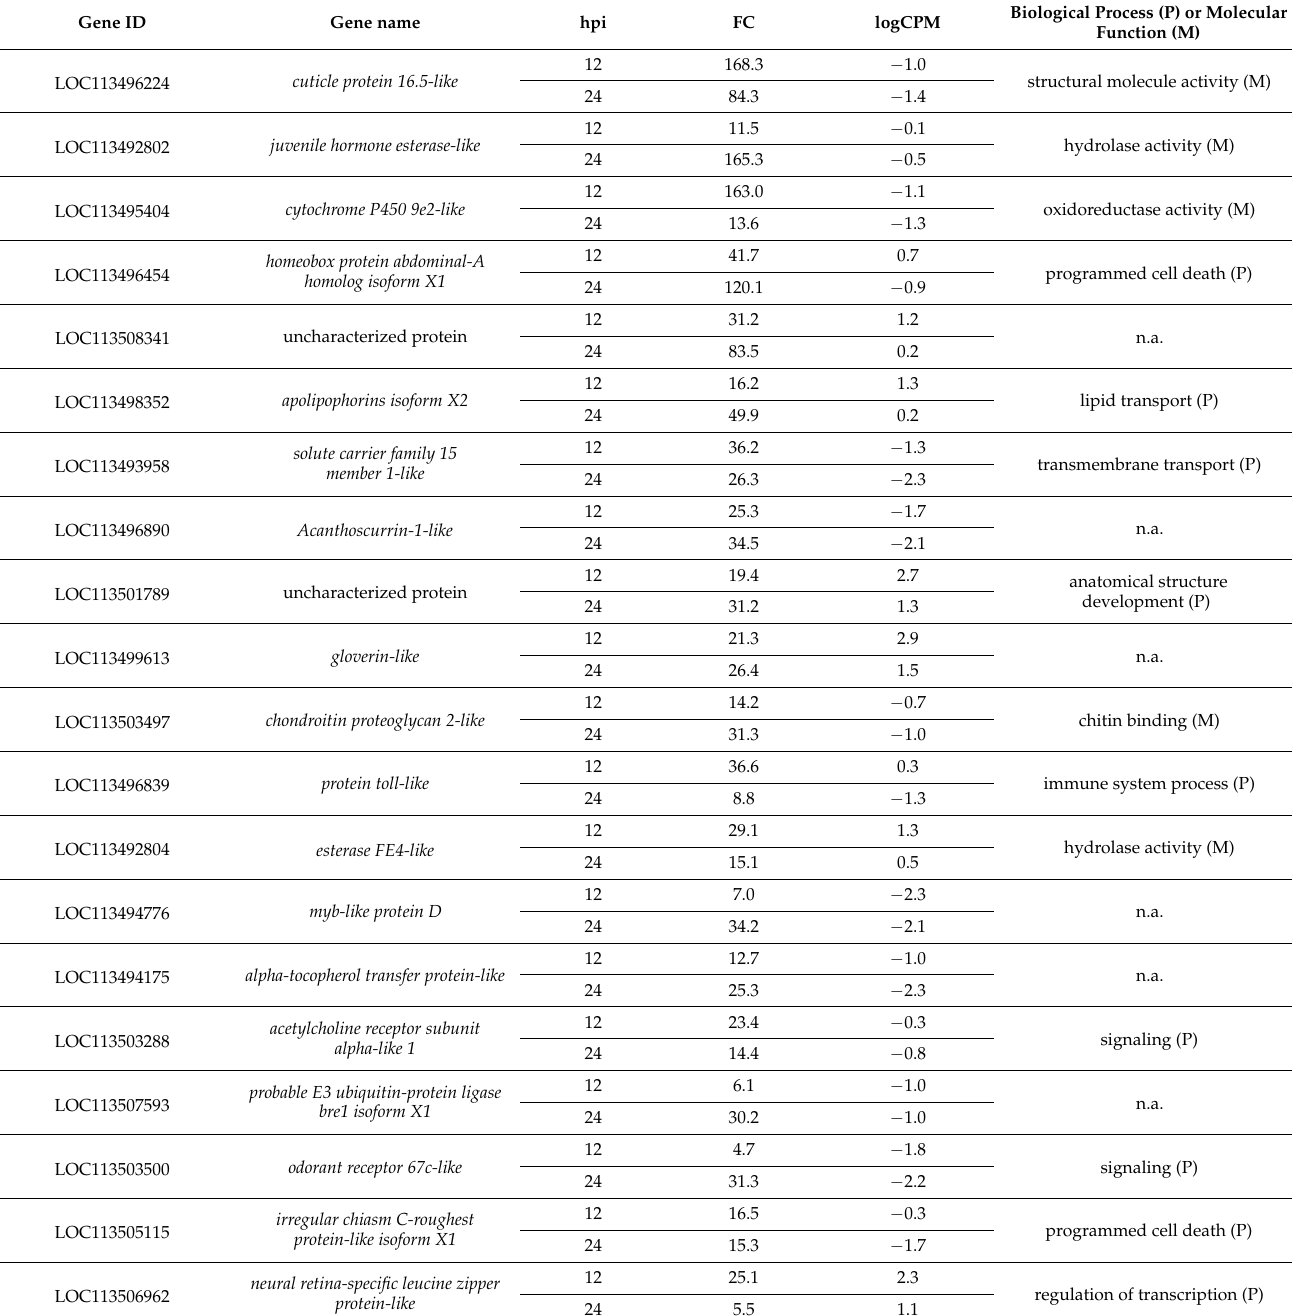
Table 2. List of TOP-20 down-regulated genes in non-adapted vs. adapted